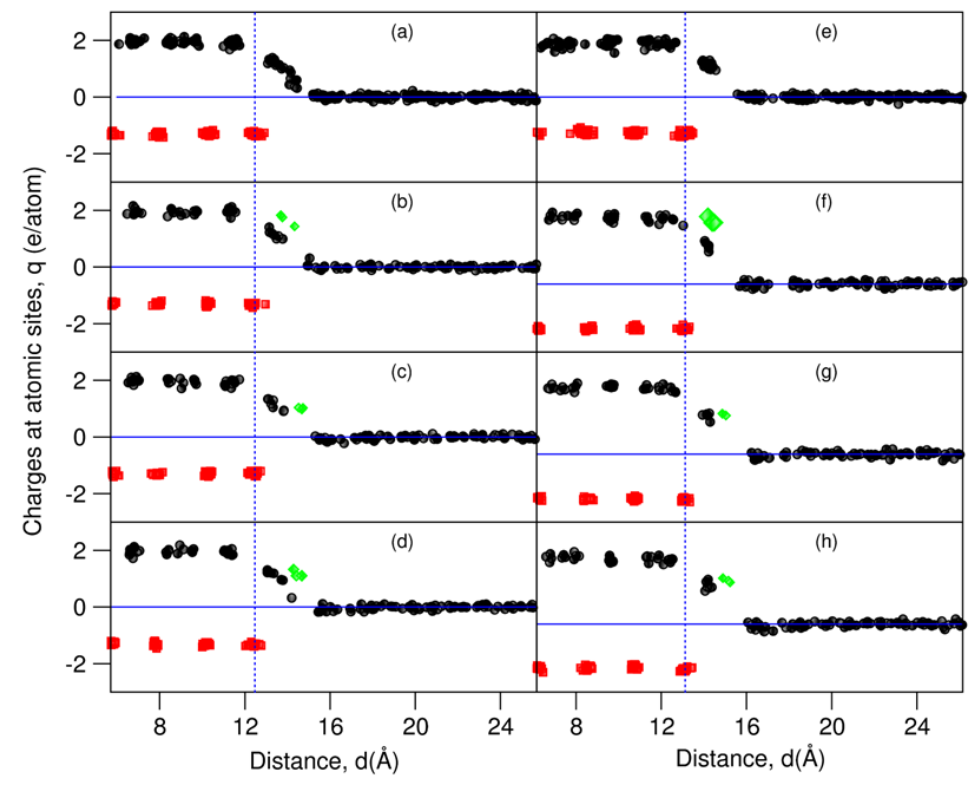
Figure 5. Charges at the atomic sites at L-Al/ γ -Al 2 O 3 interfaces, by means of Bader analysis [44,45]. The black spheres represent charges at the Al sites, red at the O sites, and green at the AE sites. ( a ) L-Al/ γ -Al 2 O 3 {1 1 1} Al-1 , ( b ) L-Al/ γ -Al 2 O 3 {1 1 1} AlMg-1 , ( c ) L-Al/ γ -Al 2 O 3 {1 1 1} AlSr-1 , ( d ) L-Al/ γ -Al 2 O 3 {1 1 1} AlBa-1 , ( e ) L-Al/ γ -Al 2 O 3 {1 1 1} Al-2 , ( f ) L-Al/ γ -Al 2 O 3 {1 1 1} AlMg-2 , ( g ) L-Al/ γ -Al 2 O 3 {1 1 1} AlSr-2 , and ( h ) L-Al/ γ -Al 2 O 3 {1 1 1} AlBa-2 .